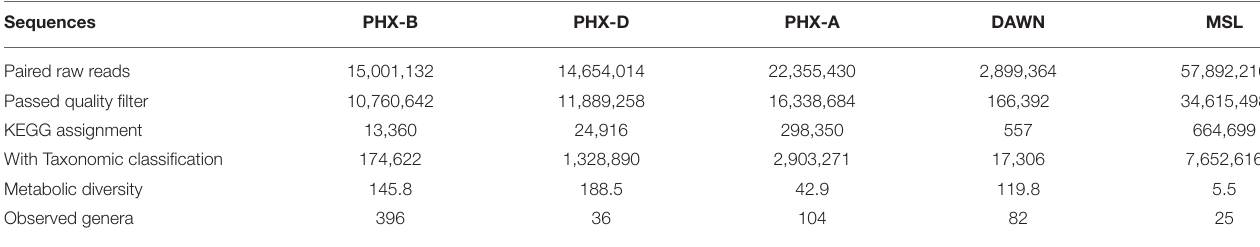
Sequences Paired raw